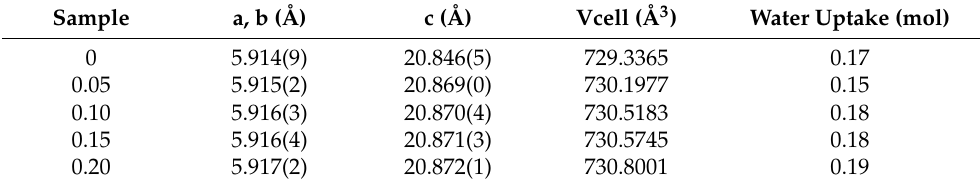
Table 1. Lattice parameters, unit cell volume, and water uptake for BaLa 2 − x Sr x In 2 O 7 − 0.5 x . Sample